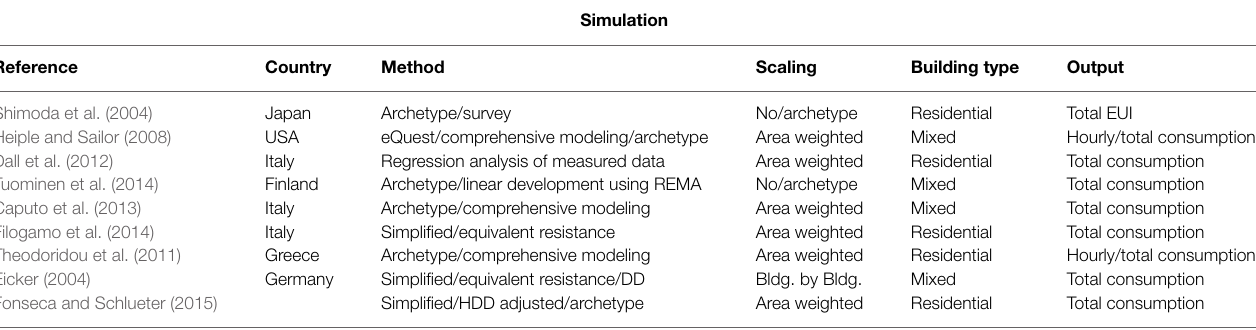
TABLE 1 | Summary of the method has been used for load prediction in DHS and type of building stocks .